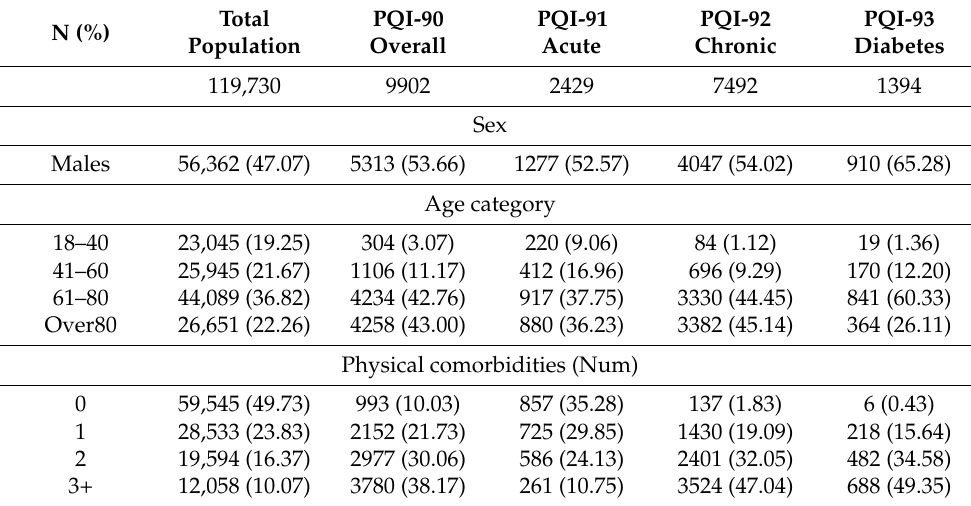
Table 1. Sex, age category, and physical comorbidities of the population under study and of the subjects considered in PQIs.